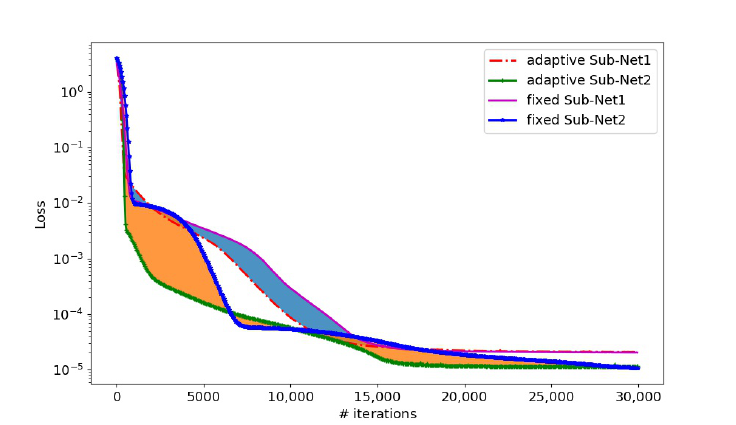
Figure 3. ( a ) The PINN solution and ( b ) the error between PINN and exact solutions for Example 1.